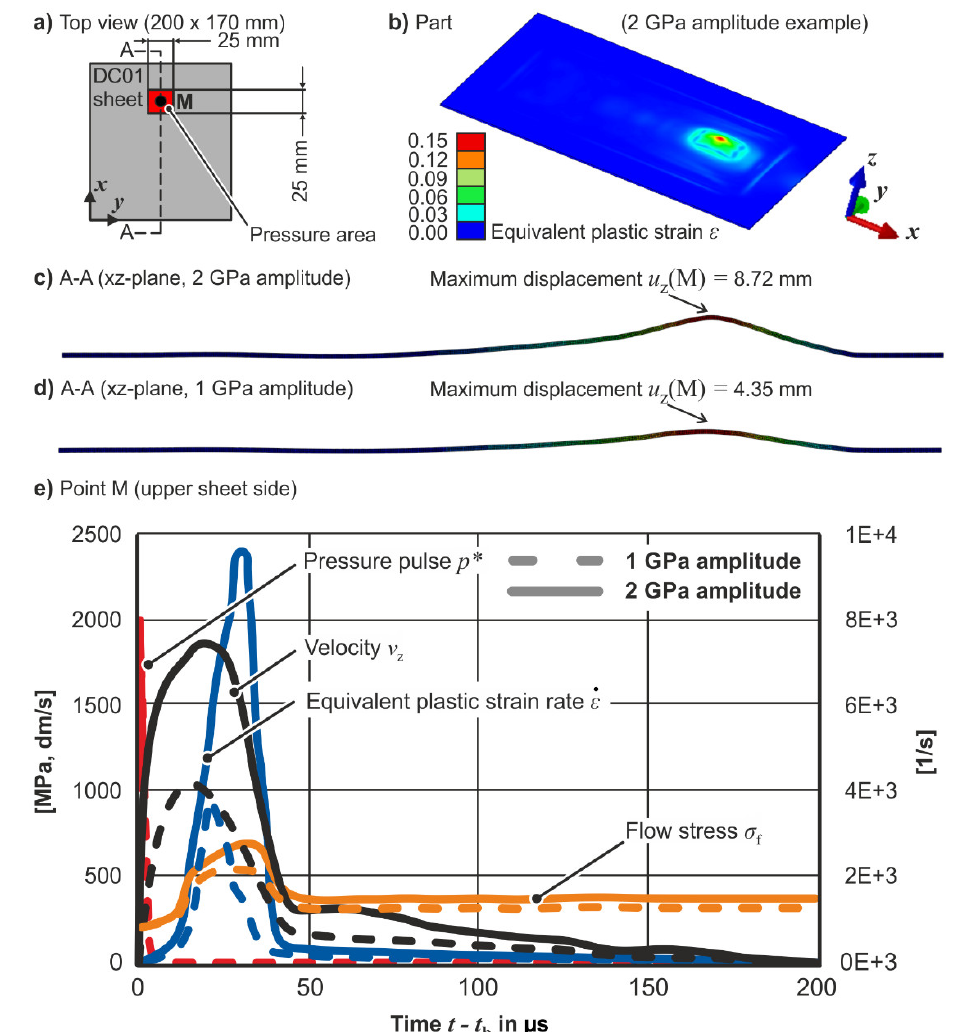
Figure 5. Numerical results for pressure distribution PD2: ( a ) sketch, ( b ) formed part, ( c – d ) sectional views at process end, ( e ) selected node-/integration point treatment.